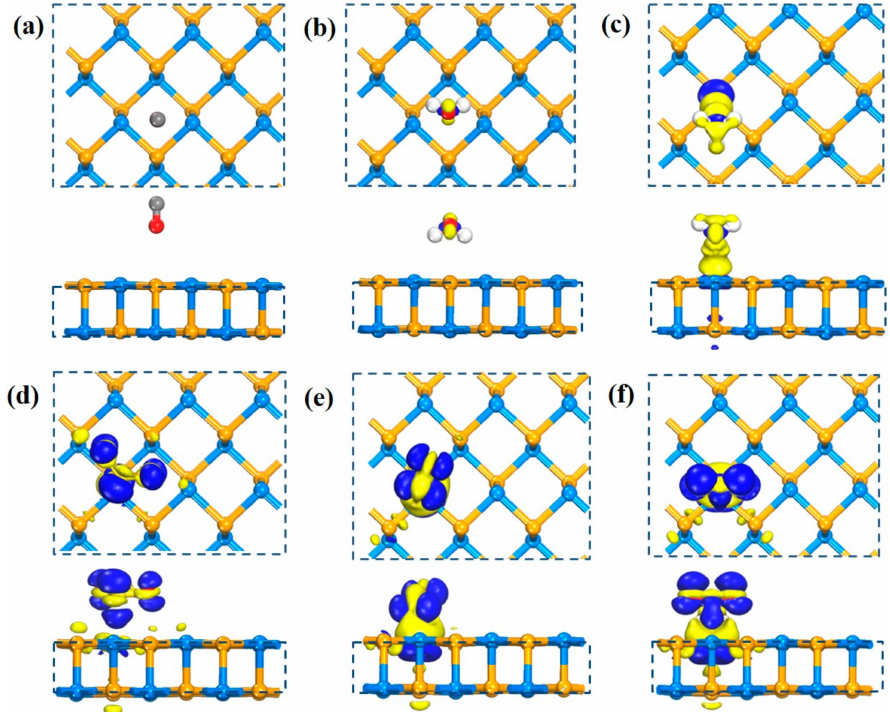
Figure 2. Front and top charge distribution view of charge density di ff erence (CDD) maps, in turn are ( a ) CO, ( b ) H 2 O, ( c ) NH 3 , ( d ) SO 2 , ( e ) NO, ( f ) NO 2 configurations. The yellow part indicates charge loss, and the blue part indicates charge accumulation. The isosurface is set as 0.01e / Å 3